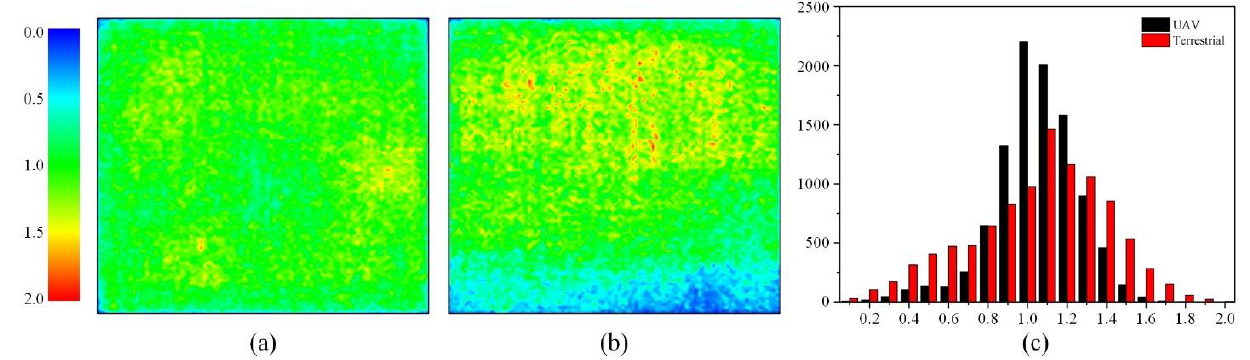
Figure 10. Tie point distributions for the Lohnhalle dataset: ( a ) aerial (UAV) and ( b ) terrestrial image spaces; ( c ) histograms.